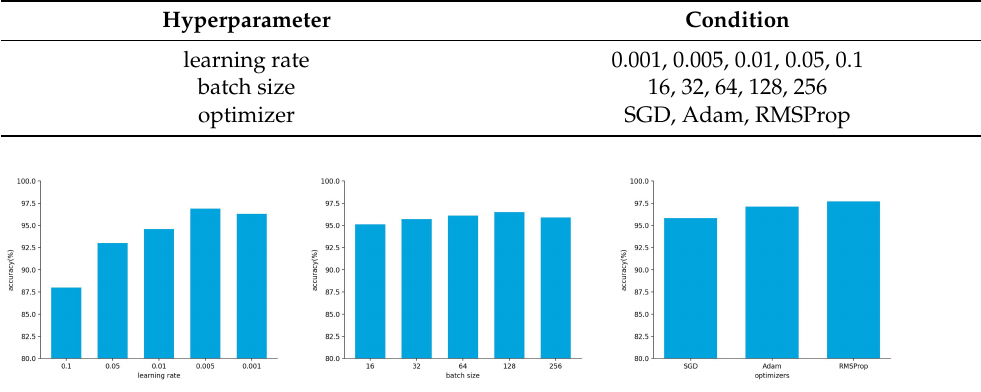
Figure 16. Hyperparameter optimization of ResNet-50.